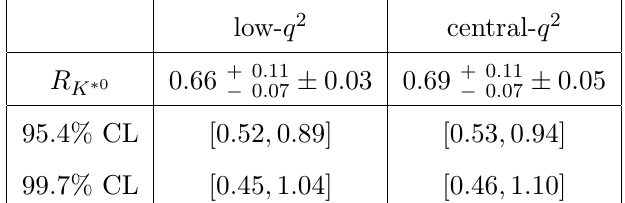
Figure 9 . Distributions of the R and combined.